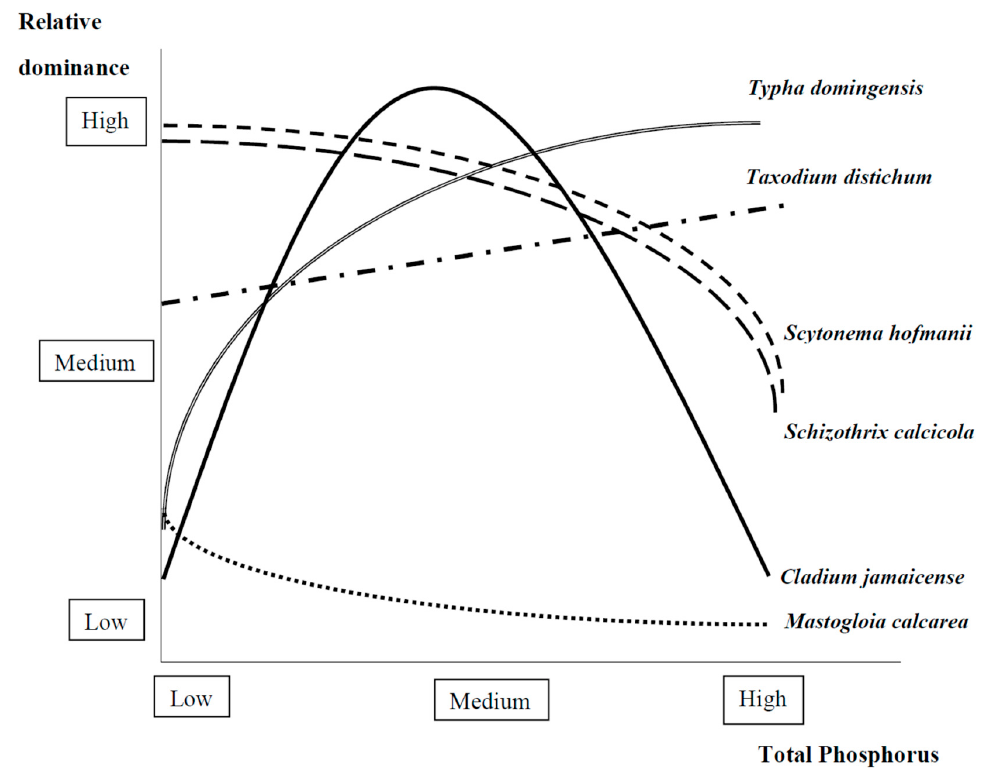
Figure 3. Examples of observed relationships between relative dominance of different foundation species and total phosphorus (TP) concentrations in the freshwater Everglades based on the literature reviewed (see